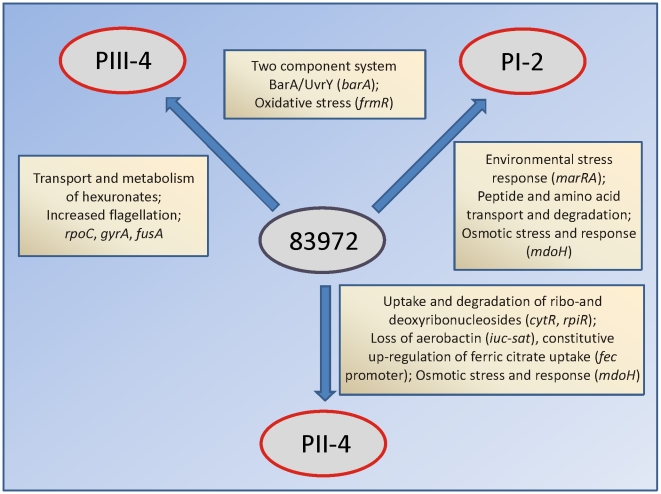
Different adaptational strategies of E. coli 83972 upon prolonged growth in the urinary bladder of human hosts.Adaptational strategies were deduced from genomic, transcriptomic and proteomic alterations in re-isolates PI-2, PII-4 and PIII-4. Genes in brackets are mutated in re-isolates relative to their parent E. coli 83972. Adaptation to individual hosts included different metabolic pathways, i.e. utilization of amino acids, hexuronates or (deoxy-) ribonucleosides; iron uptake and stress protection systems.